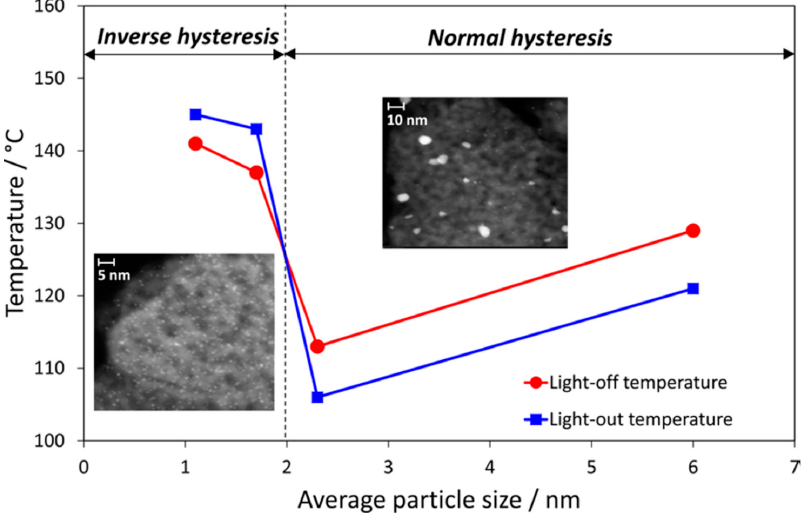
Figure 2. Light ‐ off and light ‐ out temperatures vs. average Pt particle size during CO oxidation [94]. Figure 2. Light-off and light-out temperatures vs. average Pt particle size during CO oxidation [94].